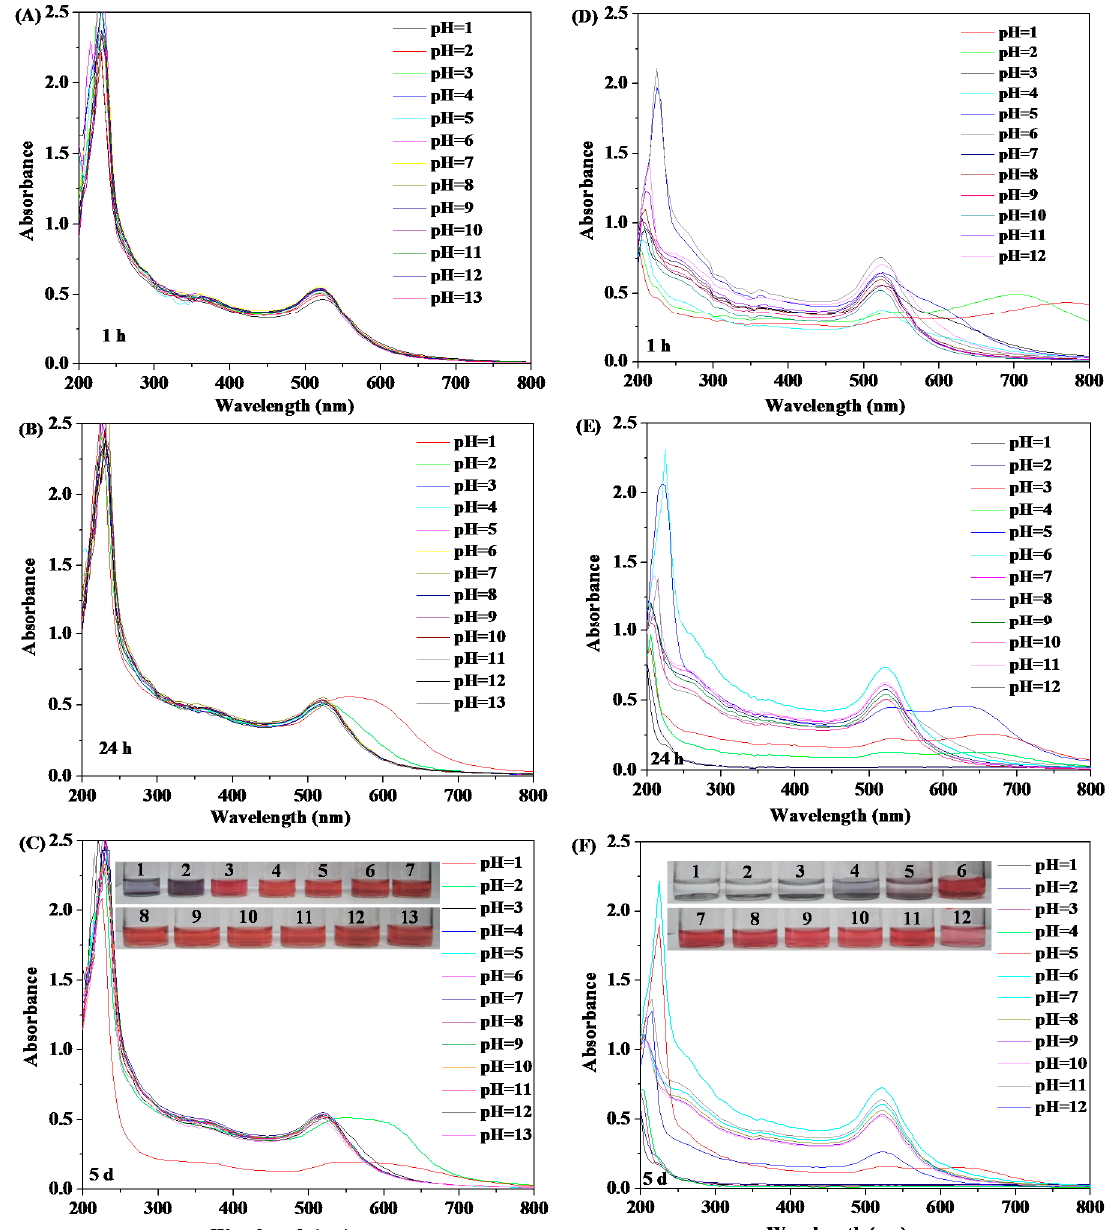
Figure 4. The UV-Vis spectra of the HPEI-IBAm functionalized AuNPs after (A) 1 h; ( B ) 24 h and ( C , Inset shows the color of the HPEI-IBAm functionalized AuNPs) 5 d under different pH value; the UV-Vis spectra of the citrate-capped AuNPs after ( D ) 1 h; ( E ) 24 h; and ( F , Inset shows the color of the citrate-capped AuNPs) 5 d under different pH value.